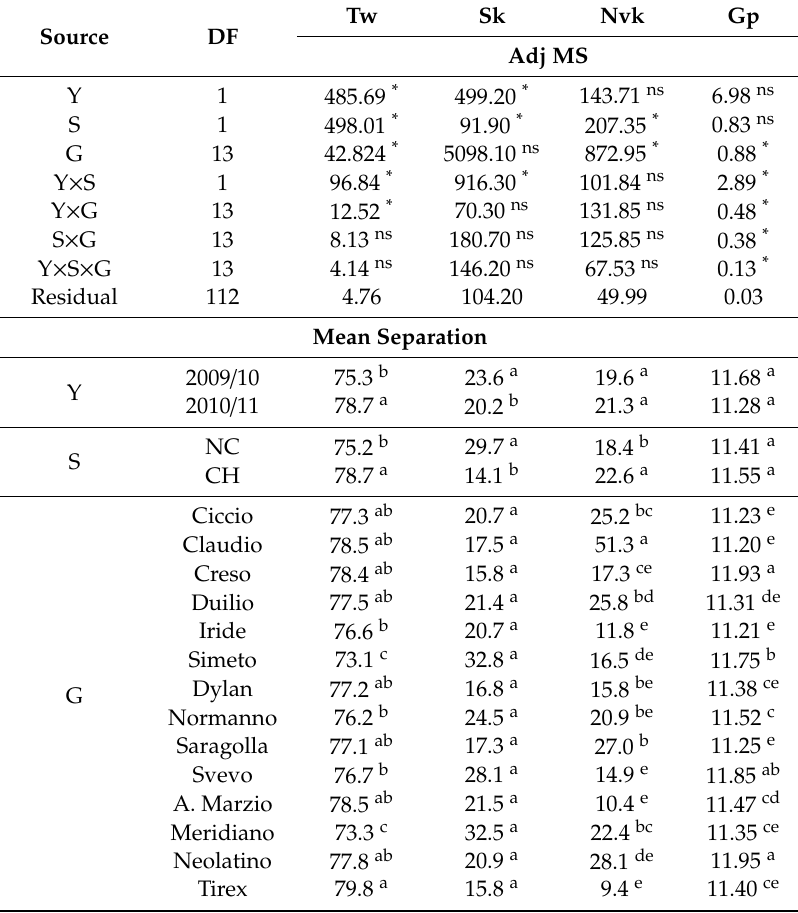
Table 4. ANOVA for grain quality features (test weight-Tw), skimpy kernels (Sk), non-vitreous kernels (Nvk), grain protein (Gp)) of durum wheat genotypes grown under two management systems in two growing seasons. Degree of freedom; adjusted mean square; and significant per p ≤ 0.05 (*),